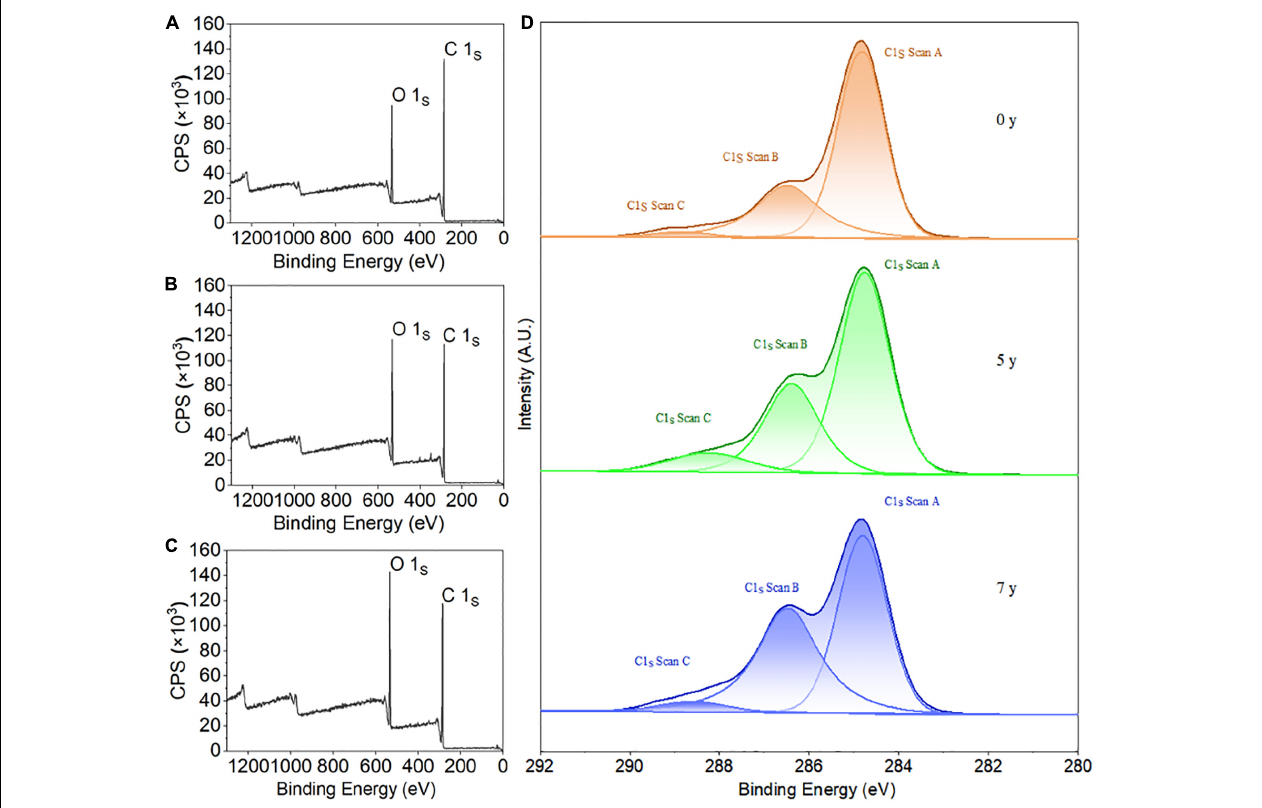
FIGURE 7 | X-ray photoelectron spectroscopy (XPS) survey spectra and C1s narrow scan of S. psammophila sand barrier; (A) 0 years of exposure; (B) 5 years of exposure; (C) 7 years of exposure; and (D) C1s narrow scan of sand